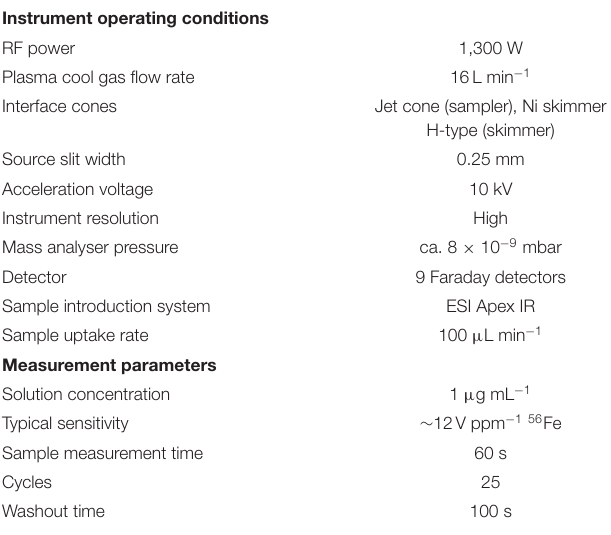
TABLE 1 | Instrumental operating conditions and measurement parameters for the Neptune Plus MC-ICPMS.